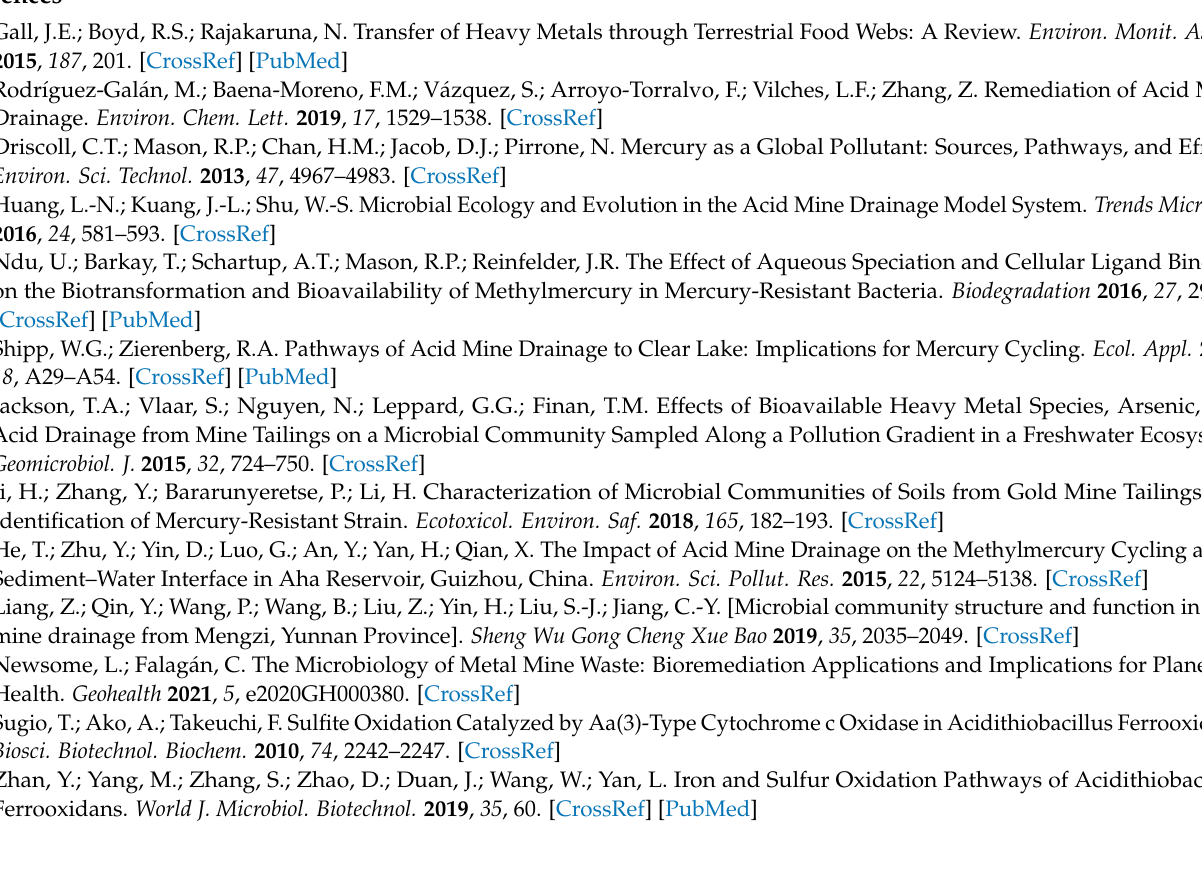
Table S2: Genes related to mercury transformation in iron/sulfur metabolism during the anaerobic Fe 3+ reduction coupled with S 0 oxidation of A. ferrooxidans ATCC 23270 in the presence of Hg 2+ ; Table S3: Genes related to mercury transformation in iron/sulfur metabolism during A. ferrooxidans ATCC 23270–pyrite interaction under aerobic conditions in the presence of Hg 2+ ; Table S4: Genes re- lated to mercury transformation in iron/sulfur metabolism during A. ferrooxidans ATCC 23270–pyrite interaction under anaerobic conditions in the presence of Hg 2+ . References [42–45] are cited in the Supplementary